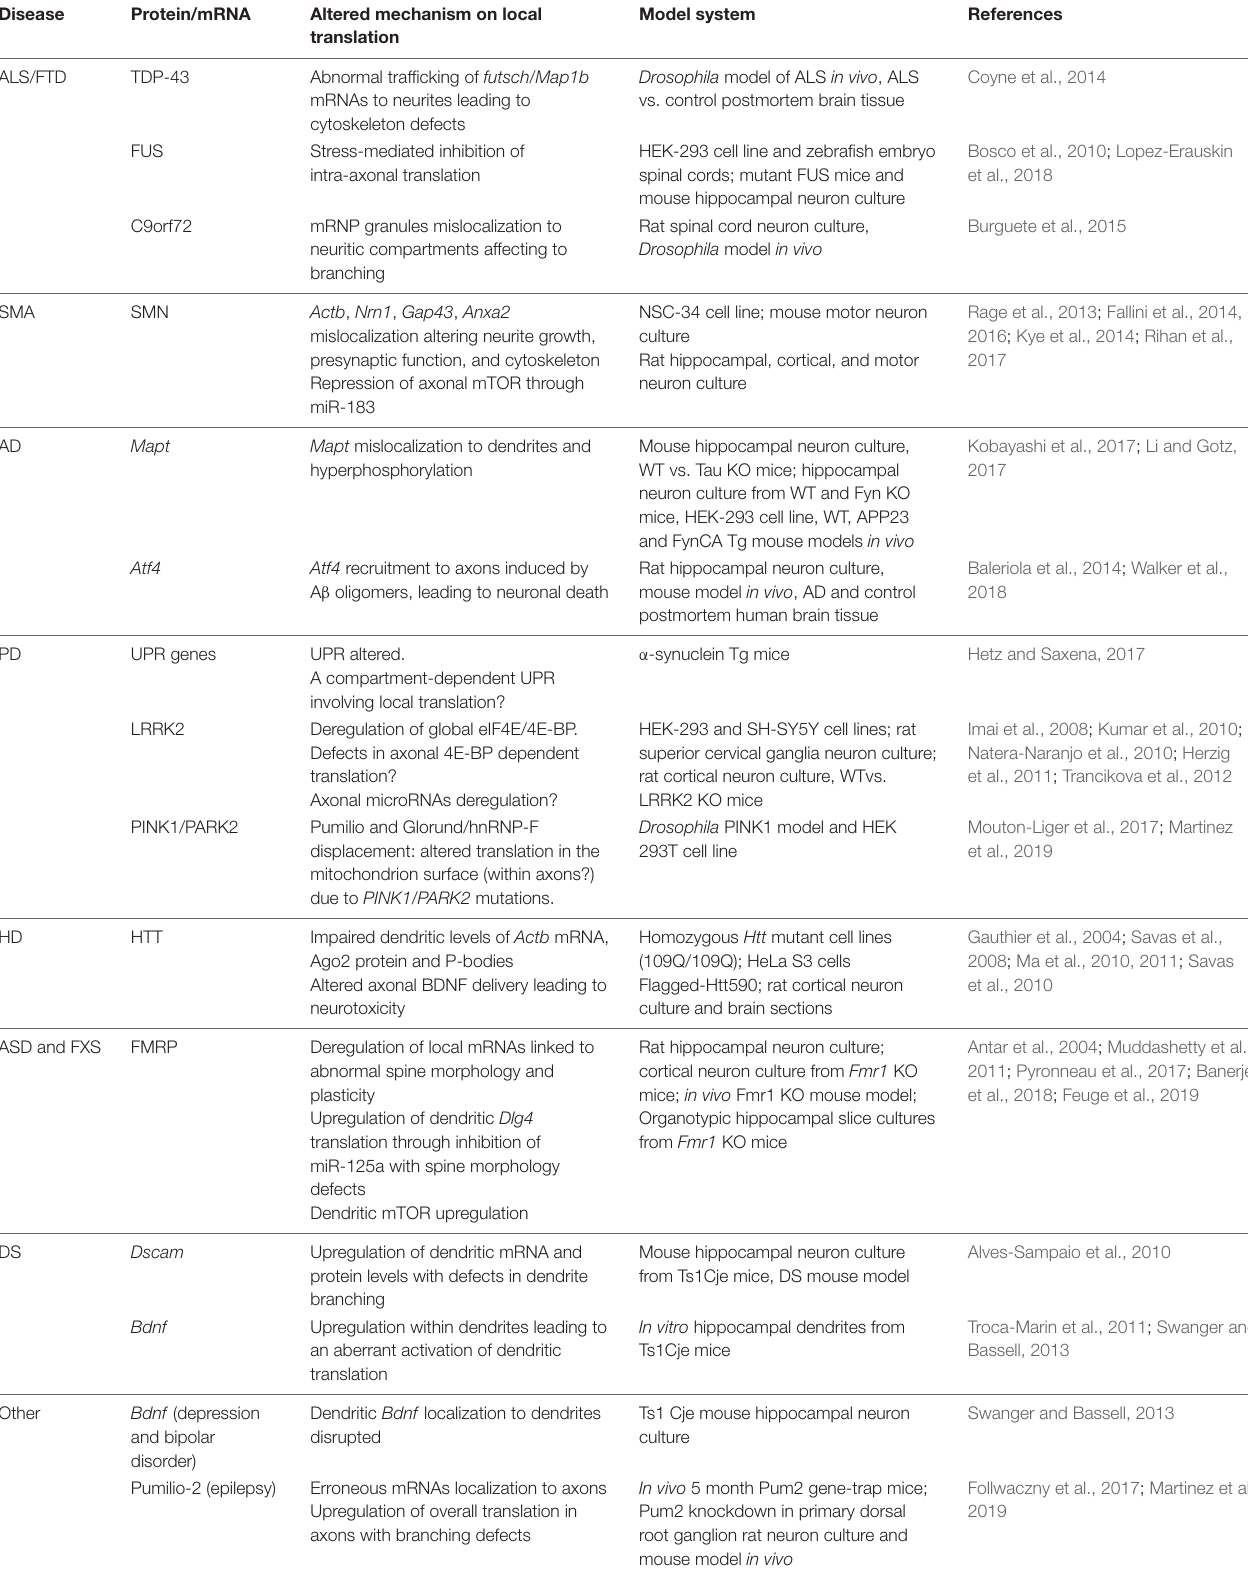
TABLE 1 | Summary of altered proteins and mRNAs involved in local translation in different nervous system